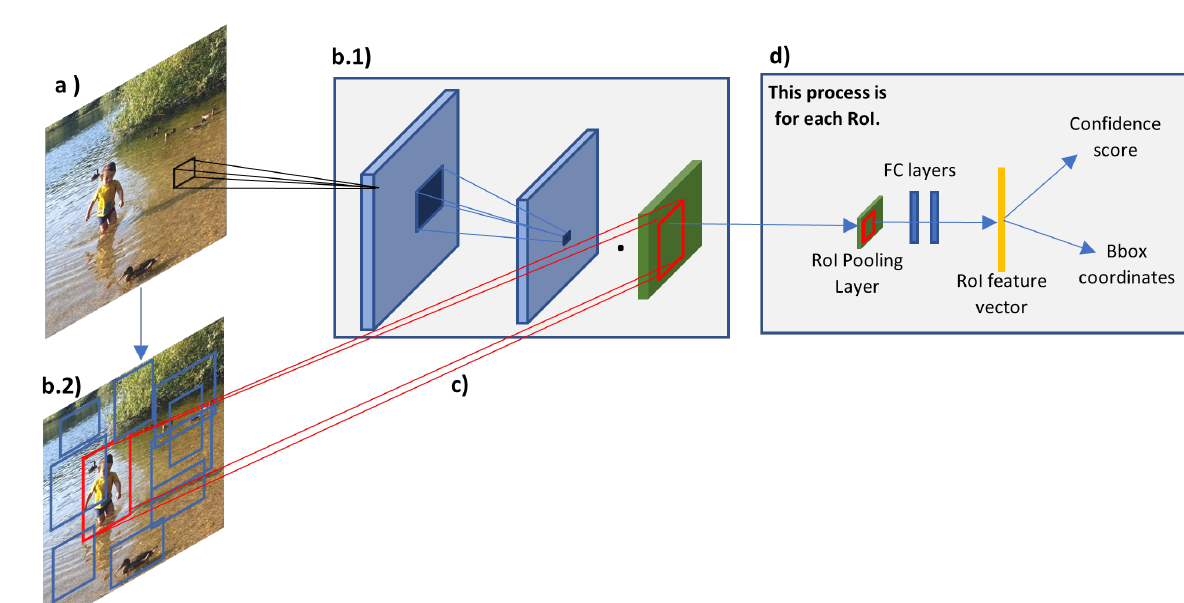
Figure 9. Fast R-CNN architecture: ( a ) Input image. ( b.1 ) CNN is used to generate feature maps of the entire input image only once. ( b.2 ) RoIs are acquired using selective searching technique. ( c ) Each RoI is projected onto the generated feature maps. ( d ) Pooling and fully connected layers are applied onto the feature maps with the projected RoI to generate a feature vector. The feature vector is used by softmax, and bbox regressor to output confidence score and bbox for each RoI